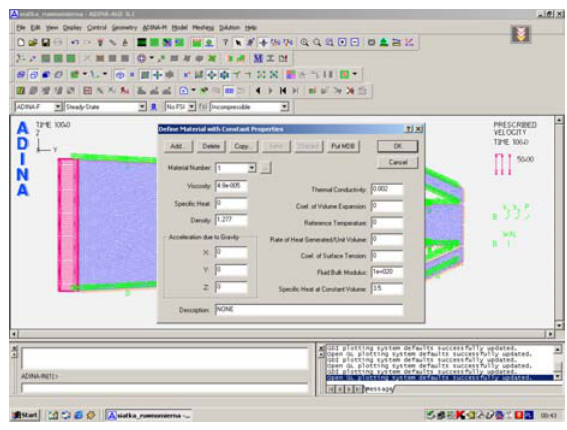
Fig 4. Defining material type and its physical